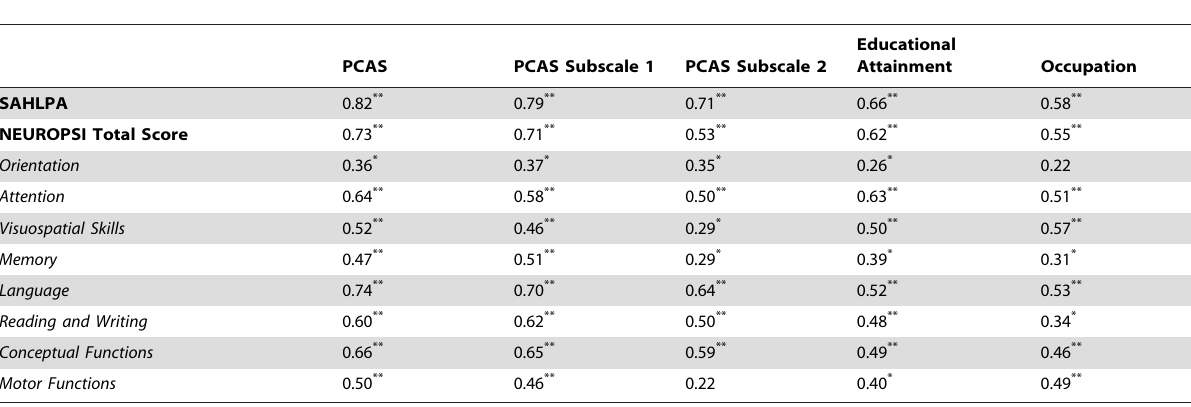
Table 3. Spearman’s correlation coefficients between the PCAS and construct